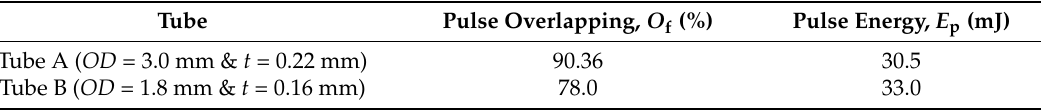
Table 5. Process parameters for experimentation with gas blowing through the tube.